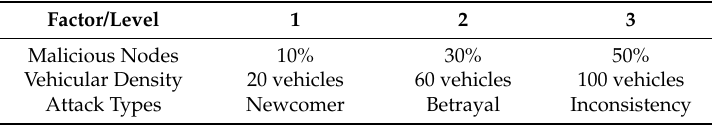
Table 3. Factors and levels of the Manhattan-Grid Scenario.